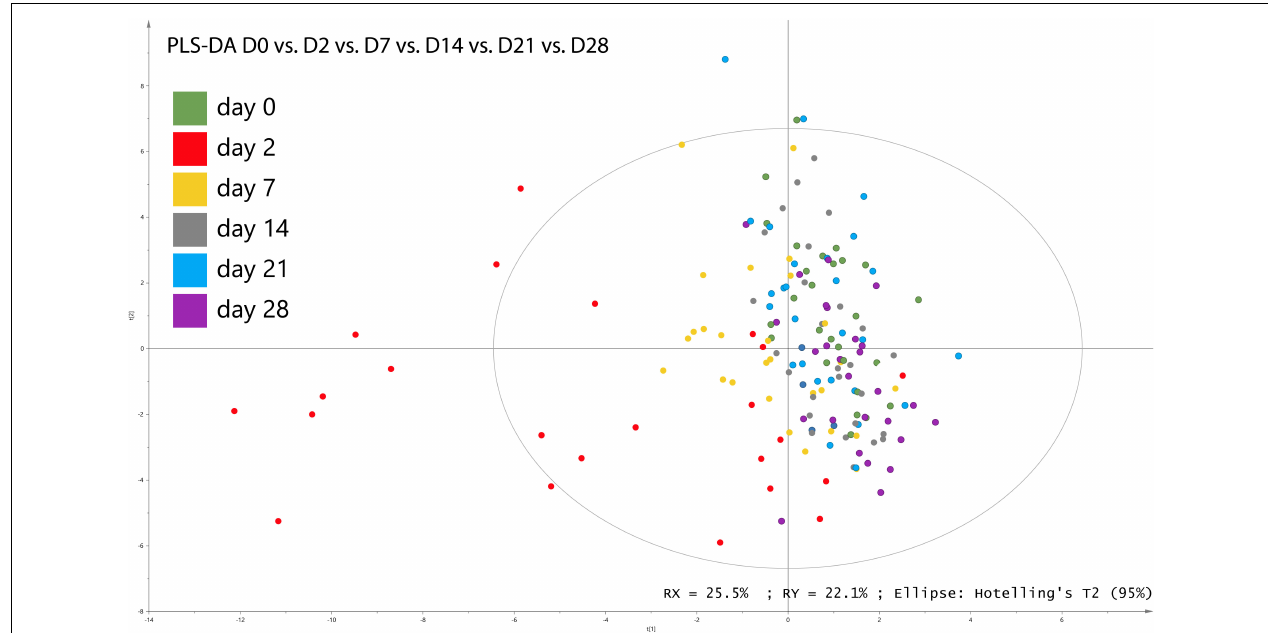
FIGURE 2 | Partial least square discriminant analysis (PLS-DA) of bacterial genera associated with days of sampling in fecal samples from horses subjected to TMS oral challenge from D0 to D4.